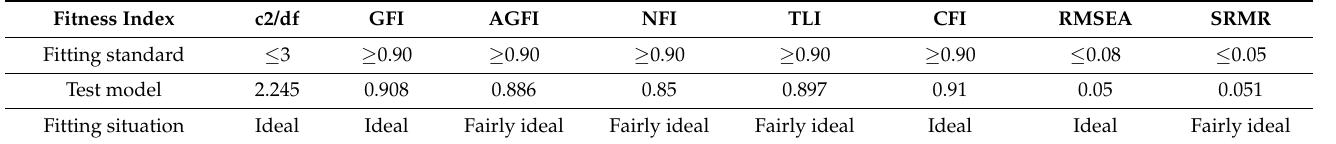
Table 3. Overall adaptability of the scale.